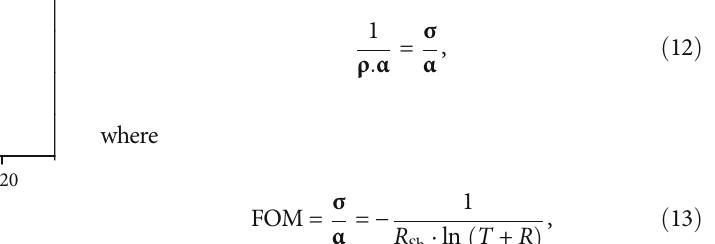
Figure 8: Electrical conductivity of thin fi lms (epoxy/silicone N- CNT wt%) versus conducting fi ller concentrations. Table 2: Variation of optical fi gure of merit versus conducting fi ller concentrations.